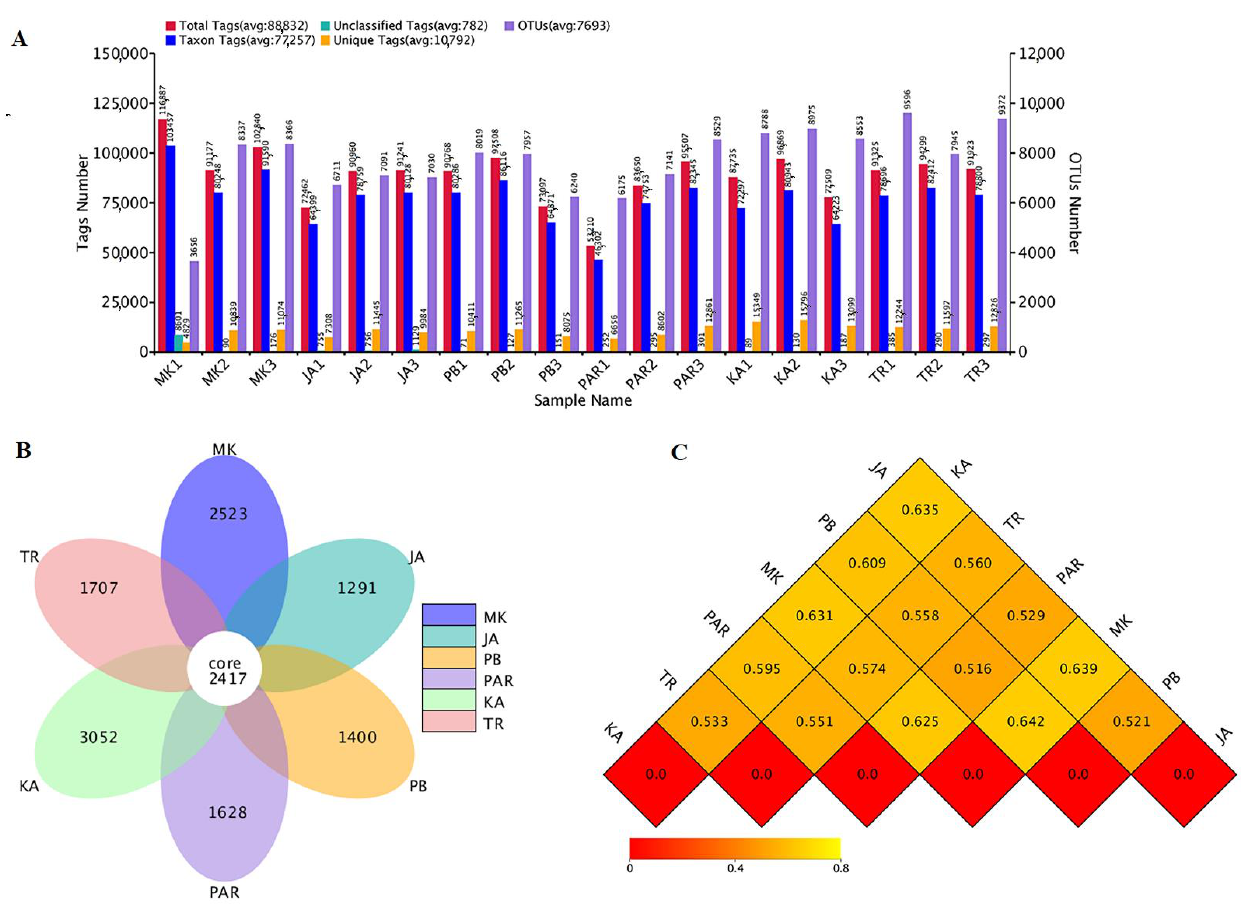
Figure 2. Statistical analyses on bacterial community structure differentiation. Tag and OTU numbers of each sampling site ( A ); OTUs flower diagram ( B ); heat map showing dissimilarity coefficients obtained from pairwise comparisons between sampling sites ( C ). The site codes are in accordance with those listed in Table 1 .